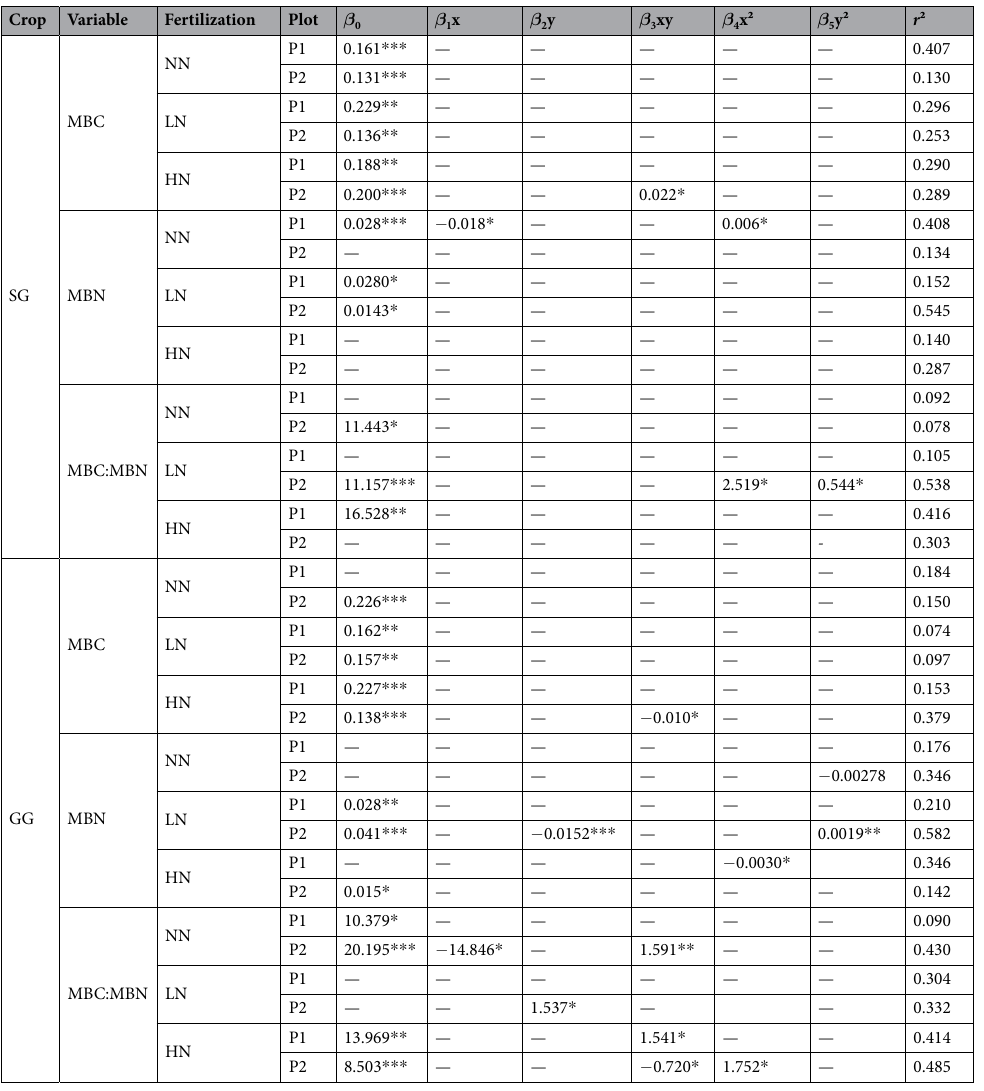
Table 3. Significant regression coefficients of trend-surface analysis and coefficients of determination ( r 2 ) for soil MBC, MBN concentrations and MBC:MBN under three N fertilization treatments (i.e. NN, LN and HN) in SG and GG cropland soils in a three-year long fertilization experimental site at the Tennessee State University (TSU) Agricultural Research Center in Nashville, TN, USA. *** and *** represent significance at P < 0.05, 0.01 and 0.001, respectively. The abbreviations are referred to Table